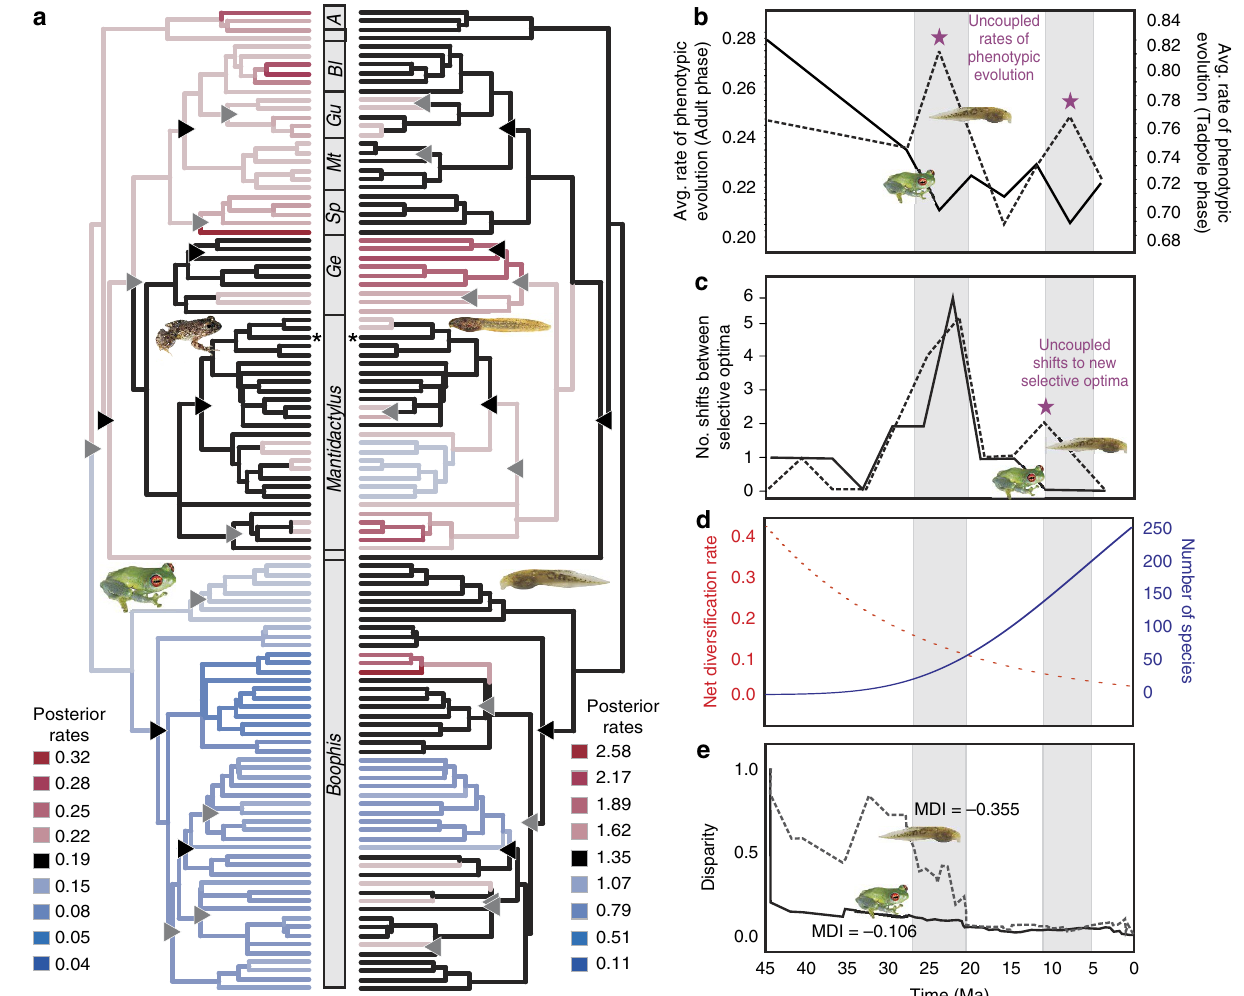
Figure 3 | Phenotypic optima and uncoupling of character evolution in mantellid frogs. ( a ) Phylogeny showing high (red) and low (blue) relative rates of phenotypic evolution in mantellids. Black branches show no rate acceleration or deceleration. Triangles mark shifts between selective optima (black, shared in adult and tadpole phenotypes; grey, unique to either of the two phases). A, Aglyptodactylus ; Bl, Blommersia ; Ge, Gephyromantis ; Gu, Guibemantis ; Mt, Mantella ; Sp, Spinomantis . The focal species Mantidactylus betsileanus is marked with an asterisk. ( b ) Rates of phenotypic evolution through time, showing uncoupled rates at ca. 24 and 7.5 Myr ago (indicated by a star and highlighted by grey bars). The continuous line represents adults, the hatched line tadpoles. ( c ) Plot of the number of shifts between selective optima through time, showing two peaks at ca. 25 and 12.5 Myr ago. The second adaptive peak is characterized by uncoupling of shifts between adults and tadpoles (star). ( d ) Variation of the diversification rate (in orange) and the predicted increase of species richness (in blue) according to the best-supported diversification model found in our study (model 3). This model of diversification assumes an exponential variation of speciation rate with no extinction. ( e ) Disparity through time (DTT) plots visualizing the dynamics of phenotypic diversification in adults and tadpoles of the family Mantellidae, for the first MDS variable. See Supplementary Fig. 5 for full plots including comparisons with simulated curves. Inset photos show representative